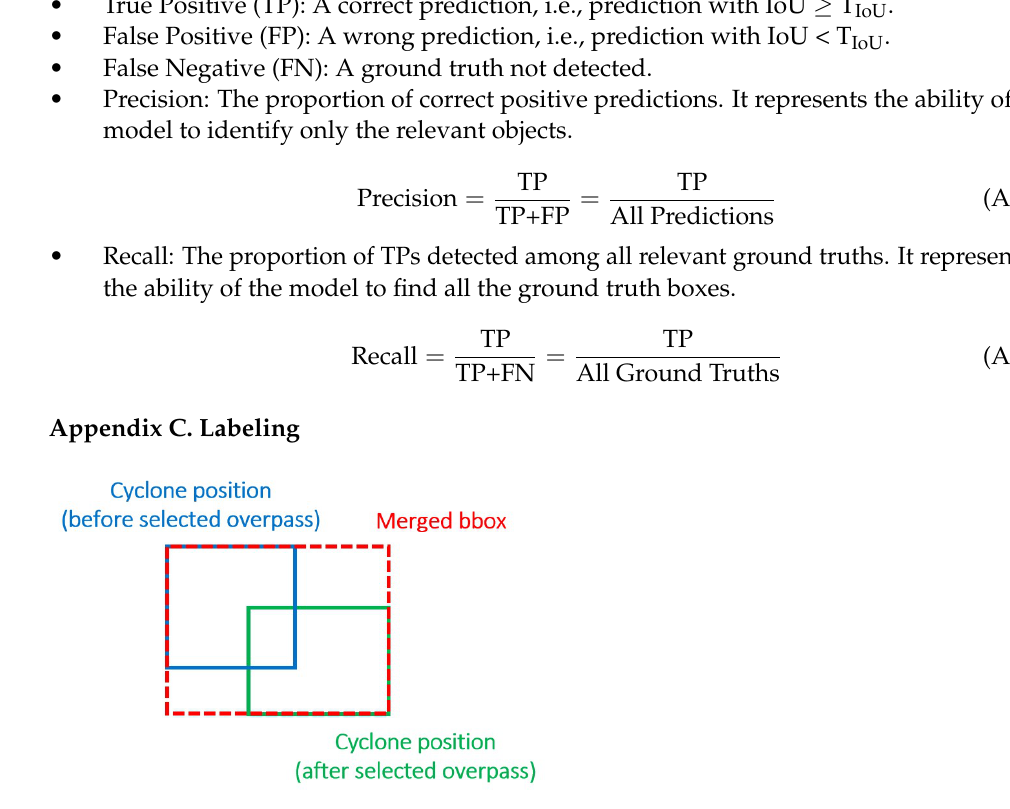
Figure A2. Merged bbox when two TC positions are matched to the same IASI overpass.